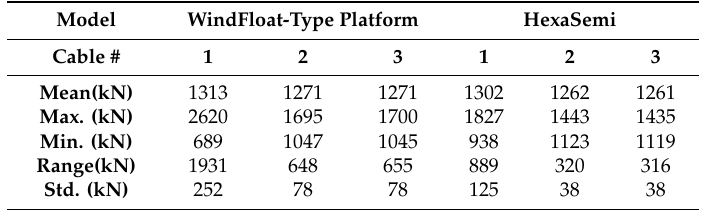
Table 10. Mooring cable tension